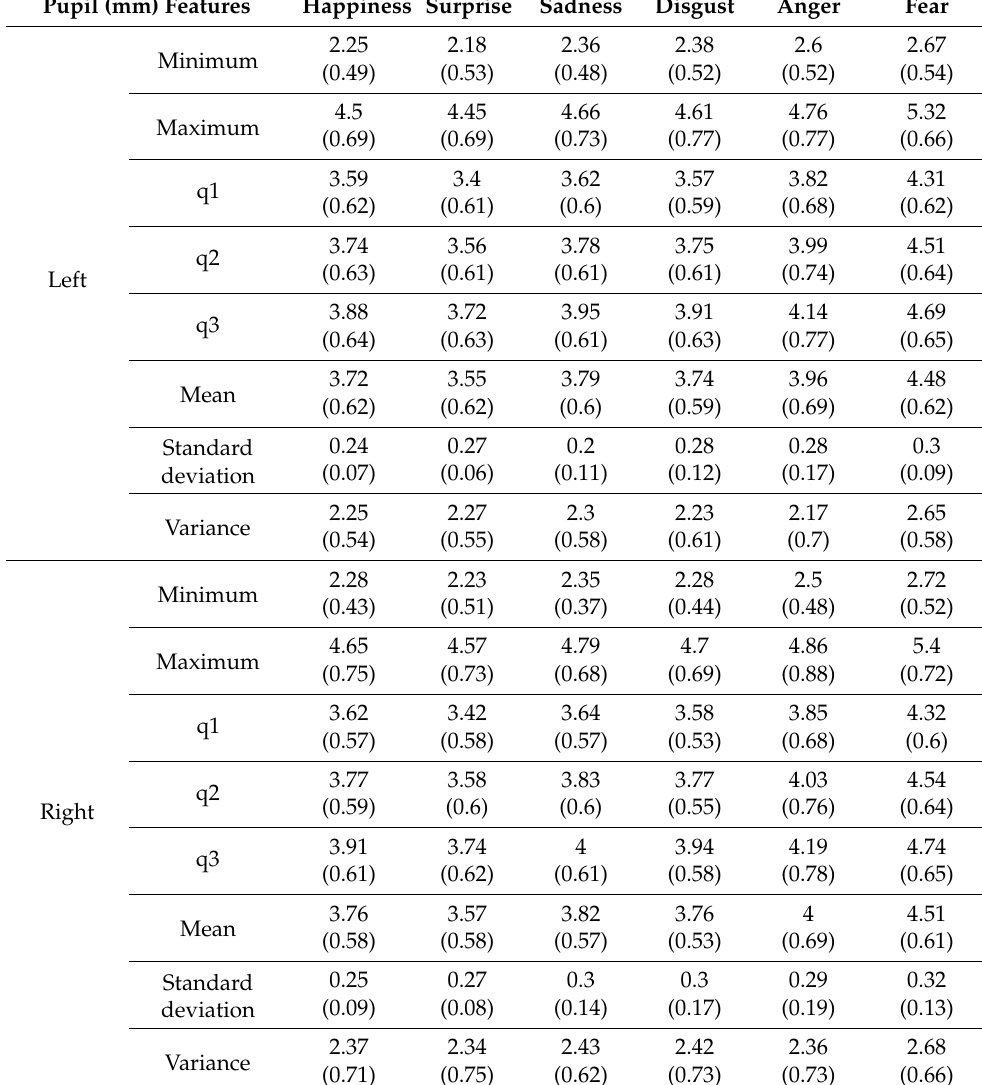
Table 2. Averaged values and standard deviations for 16 features (8 per